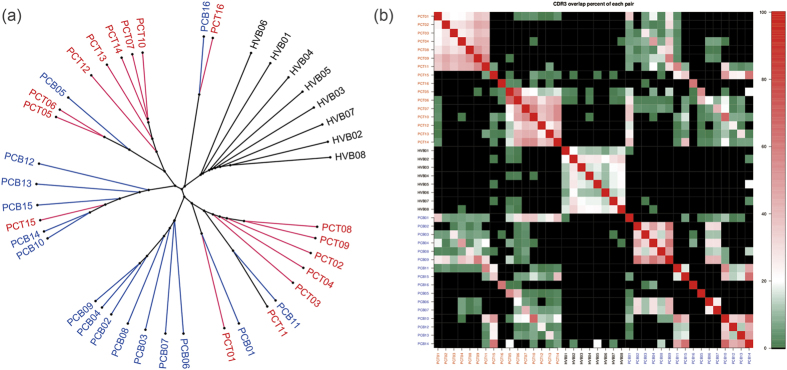
Overlap of TCR repertoires in patients.(a) The similarity of TCR repertoires from the 16 patients and 8 healthy controls was analyzed. Healthy individuals formed an independent cluster. Tumor tissue and blood samples from patients were mixed together but some clusters were formed. (b) Fussy heat map showed two clusters in tumor tissue and blood samples from the patients.